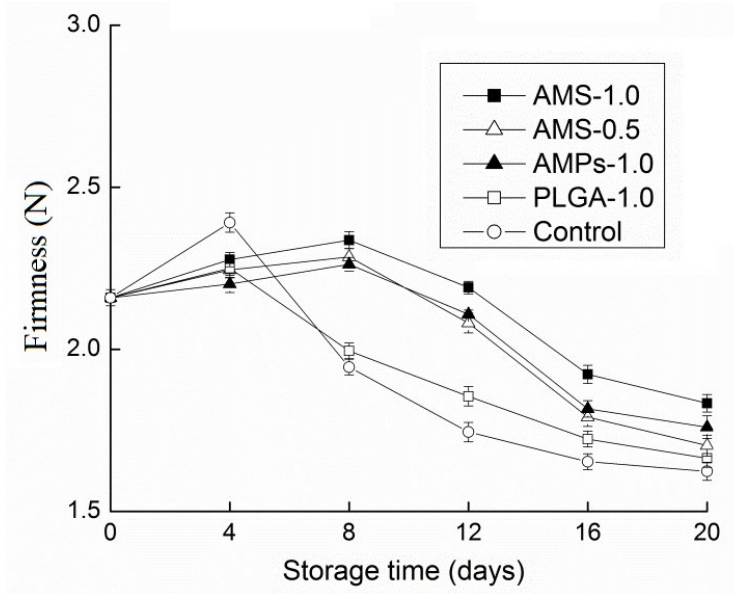
Figure 4. Effect of different antimicrobial coating on texture changes of Tricholoma matsutake stored at 4 ± 1 °C for 20 days. Each data point is the mean of three replicate samples.